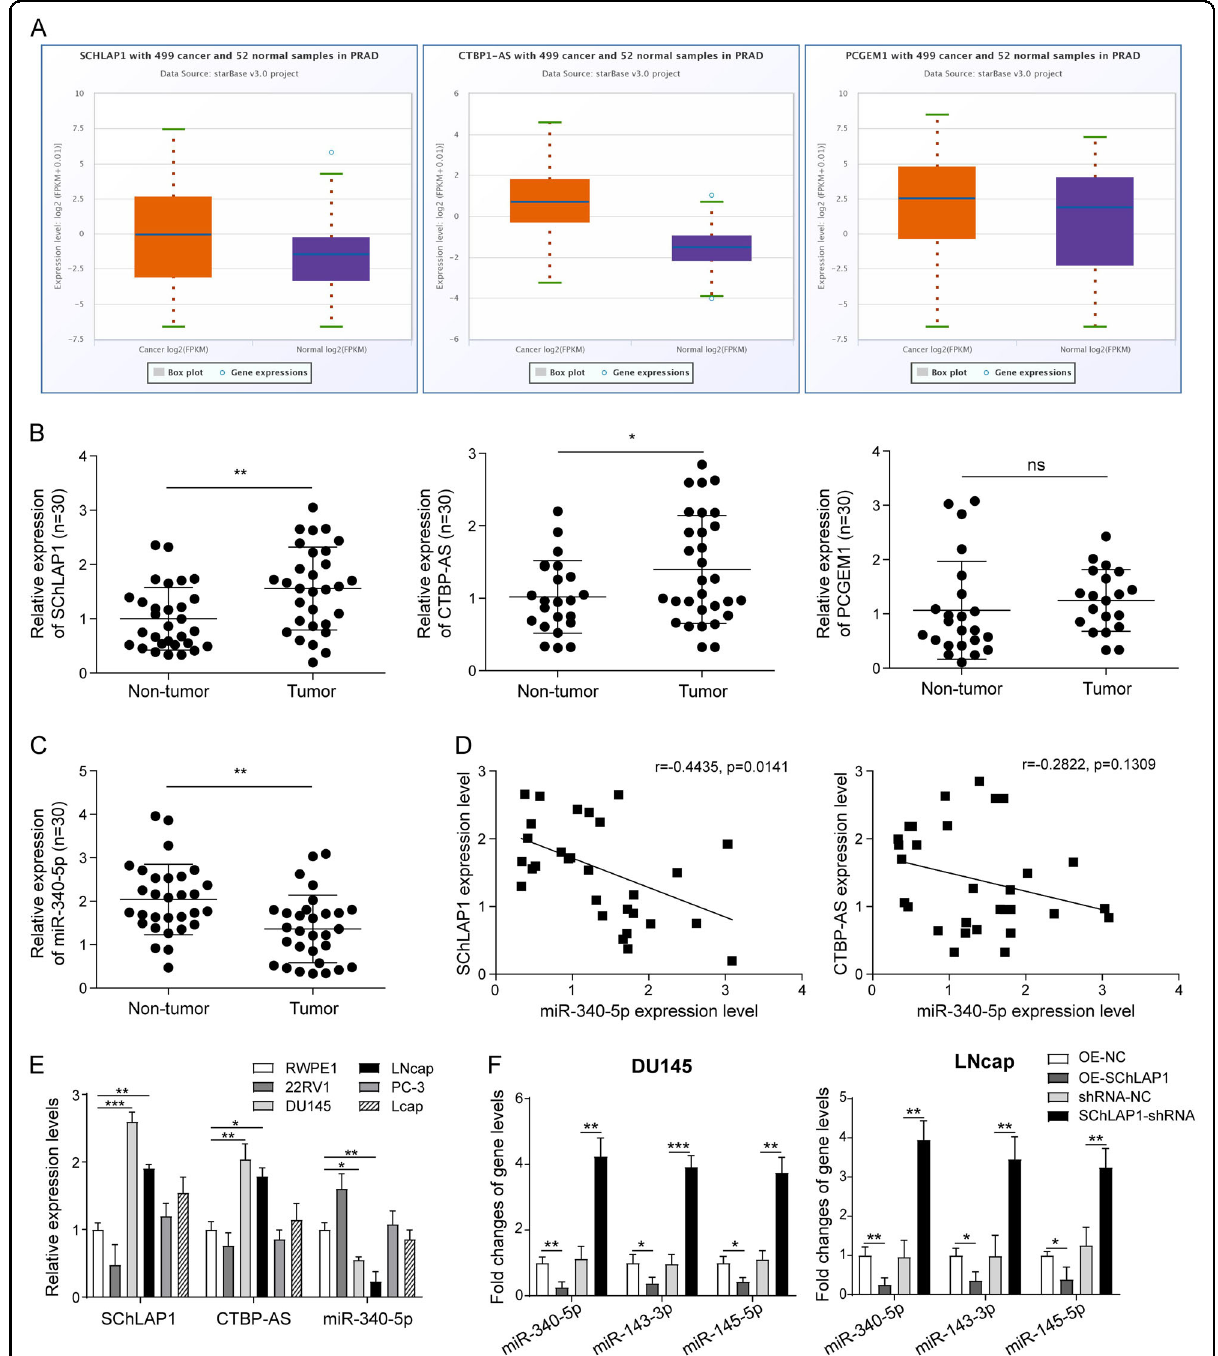
Fig. 1 LncRNA SChLAP1 was signi fi cantly overexpressed in prostate cancer tissues and cells and was negatively correlated with miR-340- 5p. A Bioinformatic analysis of lncRNA SChLAP1, CTBP1-AS, and PCGEM1 from TCGA database by the online software starBase v3.0. B QPCR analysis for the expression levels of lncRNA SChLAP1, CTBP1-AS, and PCGEM1 in 30 pair clinical specimens. Paired T test was used. n = 30, * P <0.05, ** P <0.01. C QPCR analysis for the expression levels of miR-340-5p in 30 pair clinical specimens. D The expressive correlation analysis between SChLAP1/CTBP1-AS and miR-340- 5p in the 30 pair clinical specimens. The correlation was measured by Pearson correlation analysis. E QPCR analysis for the differential expression levels of lncRNA SChLAP1, CTBP1-AS, and miR-340-5p in prostate cancer cell lines 22RV1, DU145, LNcap, PC-3, and Vcap compared to the normal prostatic epithelial cell line RWPE-1. F QPCR analysis for the expression levels of miR-340-5p, miR-143-3p, and miR-145-5p in DU145 and LNcap cells with SChLAP1 overexpression or knockdown. The results are presented as the mean±SD. * P <0.05, ** P <0.01, *** P <0.001. SChLAP1 second chromosome locus associated with prostate-1, CTBP1-AS C-terminal binding protein 1 antisense, PCGEM1 prostate cancer gene expression marker 1, TCGA The Cancer Genome Atlas.